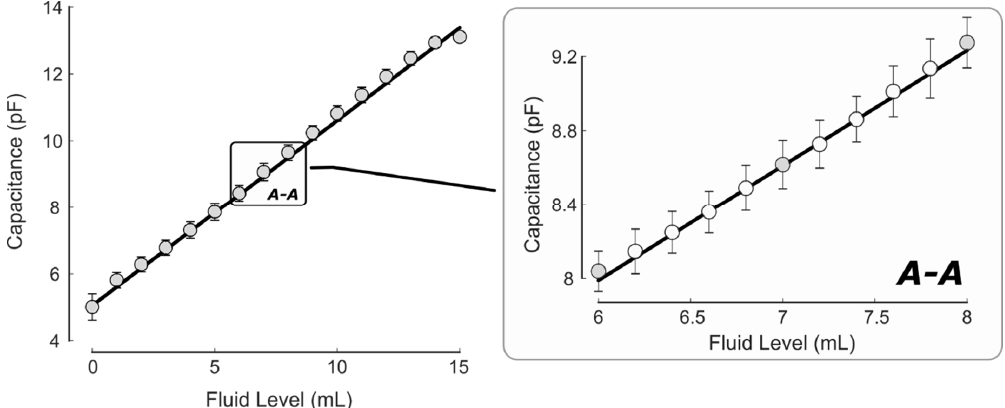
Figure 3. Fluid level sensor calibration results for changes over the entire bottle volume ( left ) and a higher resolution test with 0.2 mL increments ( right ). Results indicate a linear relationship between fluid volume and capacitance reading with a resolution of approximately 0.4 mL.